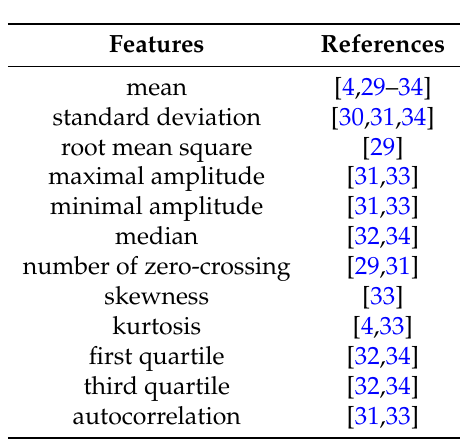
Table 2. Features extracted in time domain.